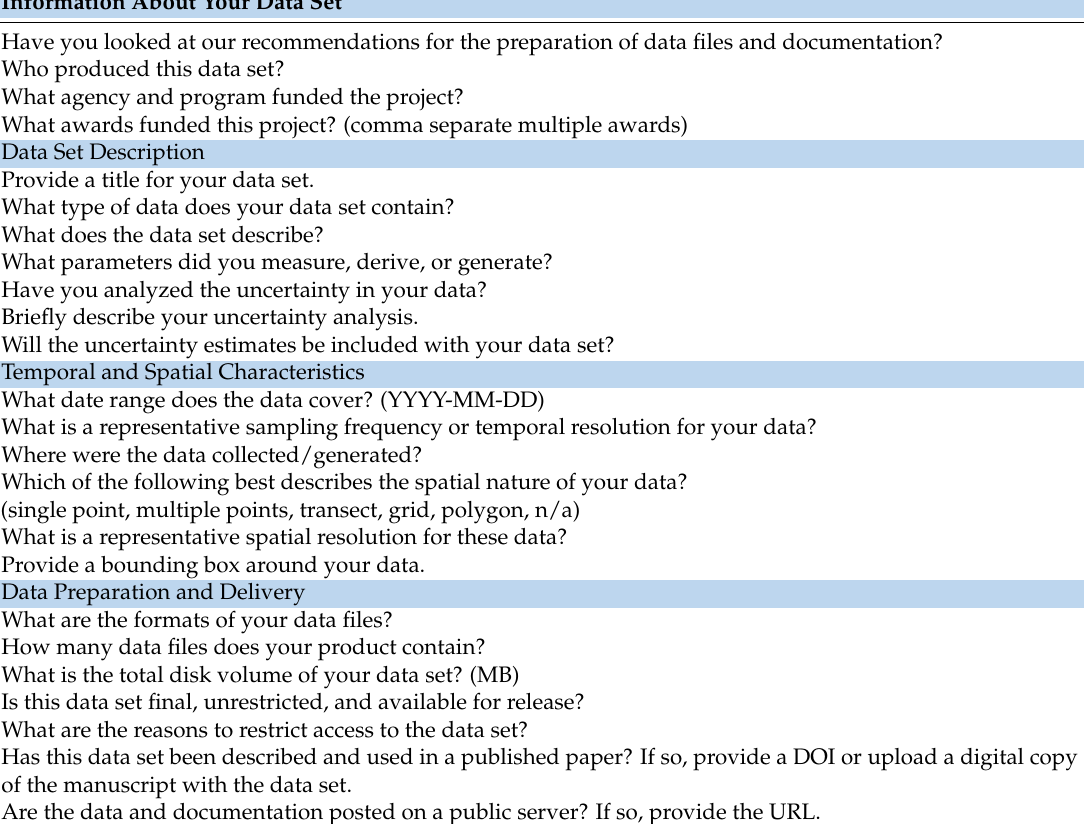
Table 1. Data Provider questions